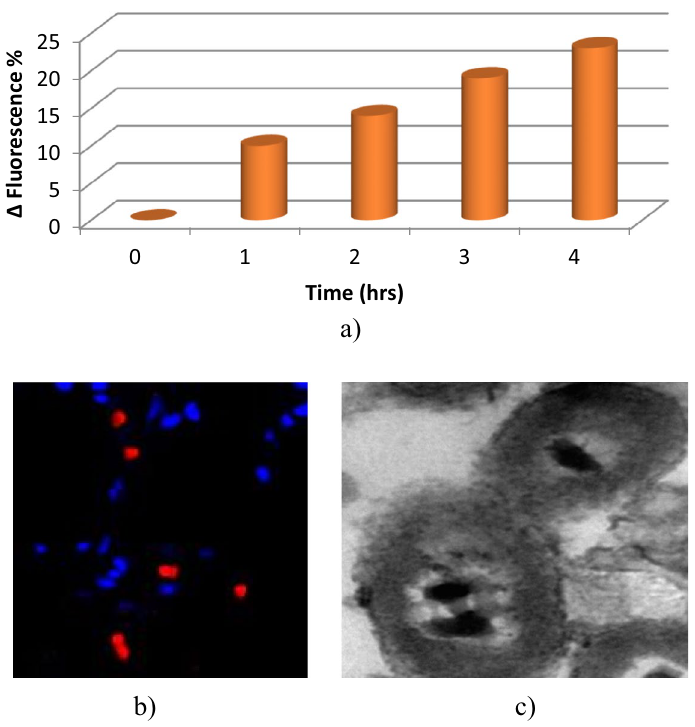
Figure 7. Antibacterial effect of CuO-NWs & CuO-NPs against Acinetobacter baumannii strains represented in ROS generation with a fluorescent HPF probe ( a ), fluorescent images of Acinetobacter baumannii cells after treatment with live/dead fluorescent dyes to indicate cell membrane permeability ( b ) and transmission electron microscopic (TEM) study ( c